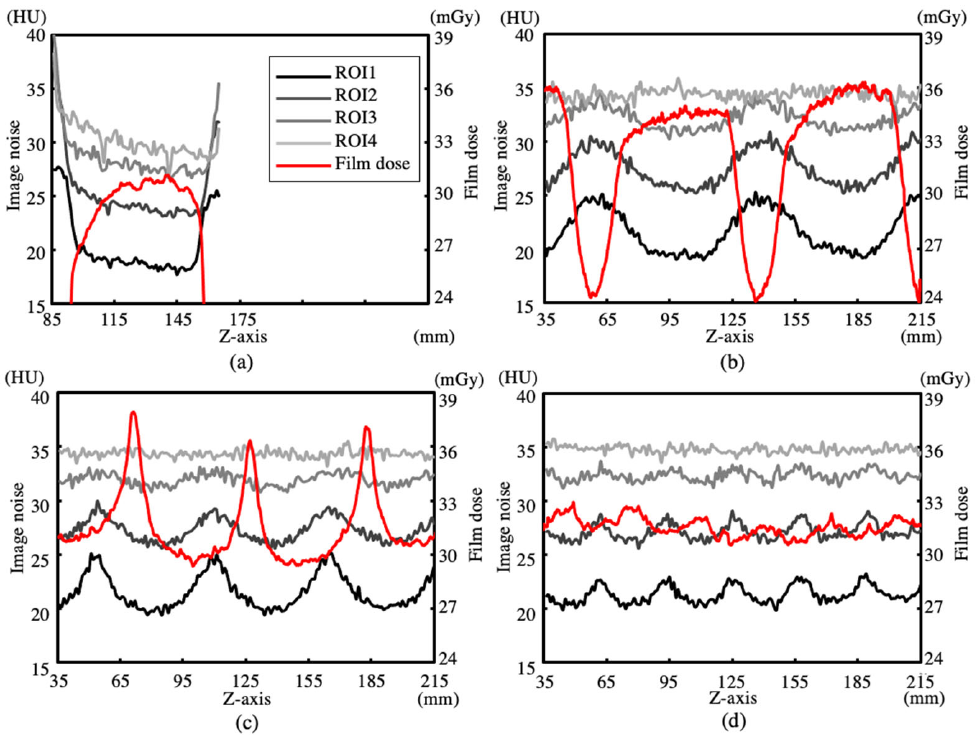
Figure 3. Dose (z) and Noise (x, y, z) for ROI1, ROI2, ROI3, and ROI4 in FBP images. ( a ) Axial scan. Helical scans with pitch values of ( b ) 0.992, ( c ) 0.696, and ( d ) 0.399.